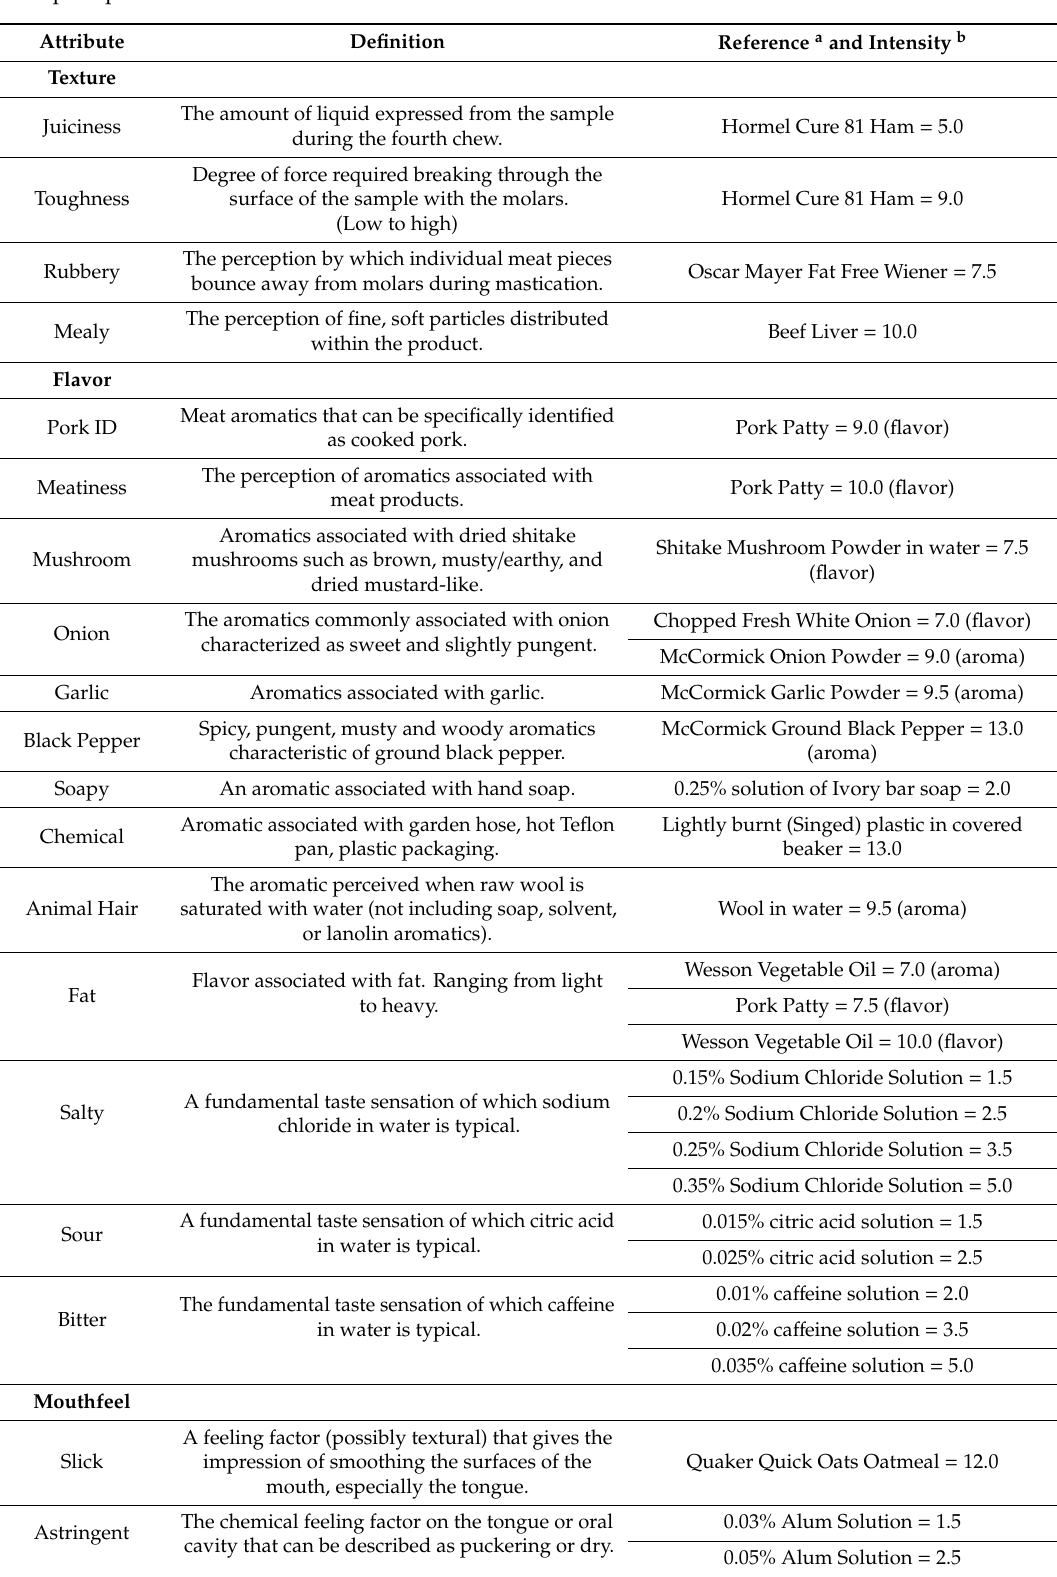
Table 2. Terms, definitions, references, and intensities for describing texture and flavor characteristics of pork